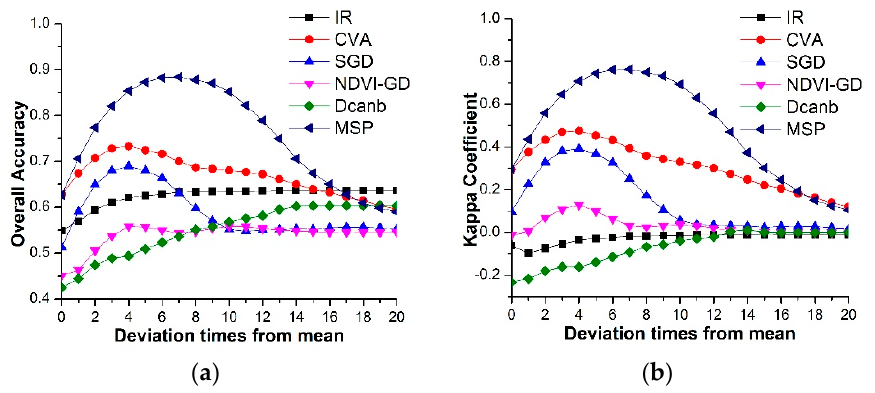
Figure 6. Accuracy assessment curves. ( a ) Overall accuracy; ( b ) kappa coefficient. Both ( a ) and ( b ) are the deviation times from the mean of the change magnitude ( x -axis) with units of 0.25 multiplied by the standard deviation.